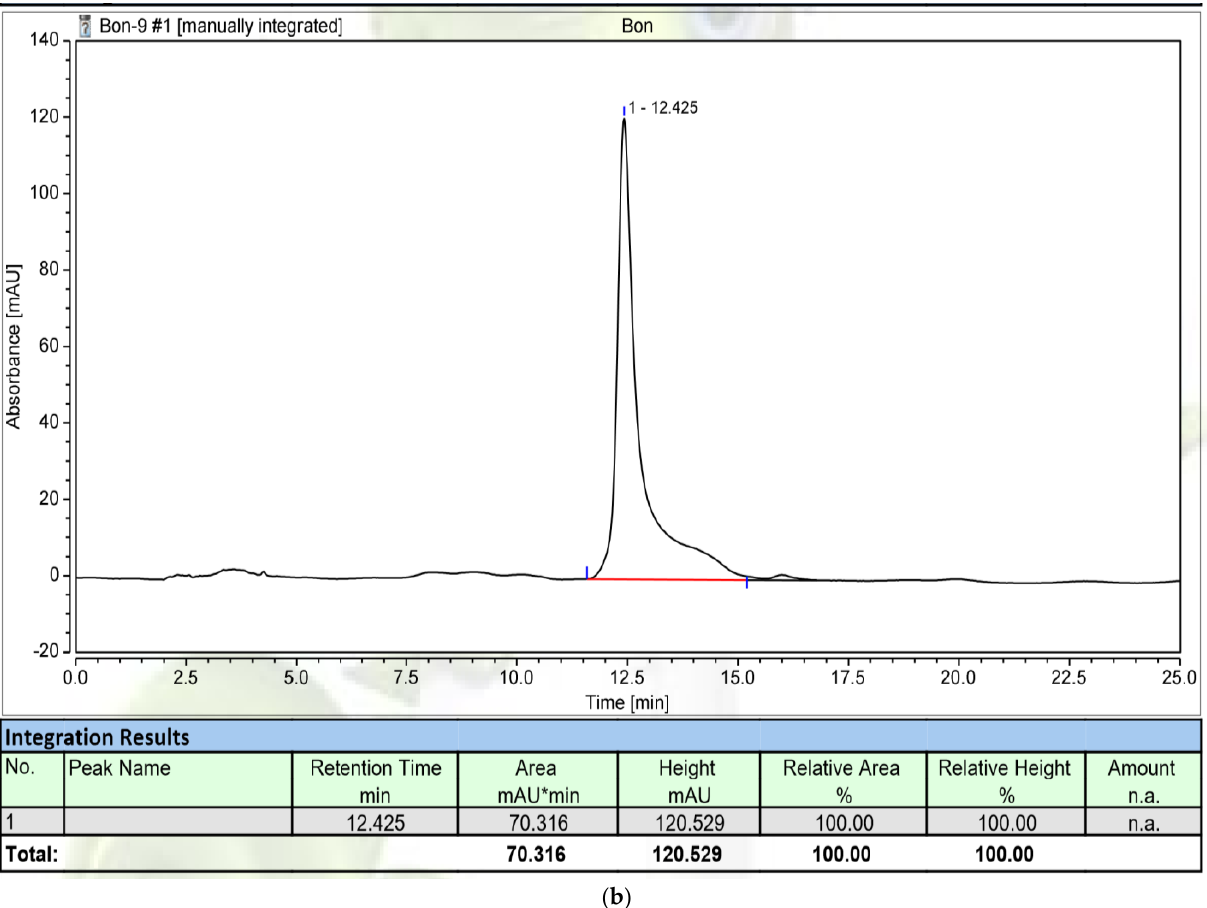
Figure 5. The high-performance liquid chromatography (HPLC) profiles of prodigiosin purified in this work ( a ), and a reference PG compound ( b ) obtained in our previous study [26]. The retention time (RT) of purified prodigiosin and the reference PG was recorded at 12.368 min and 12.425 min, respectively.